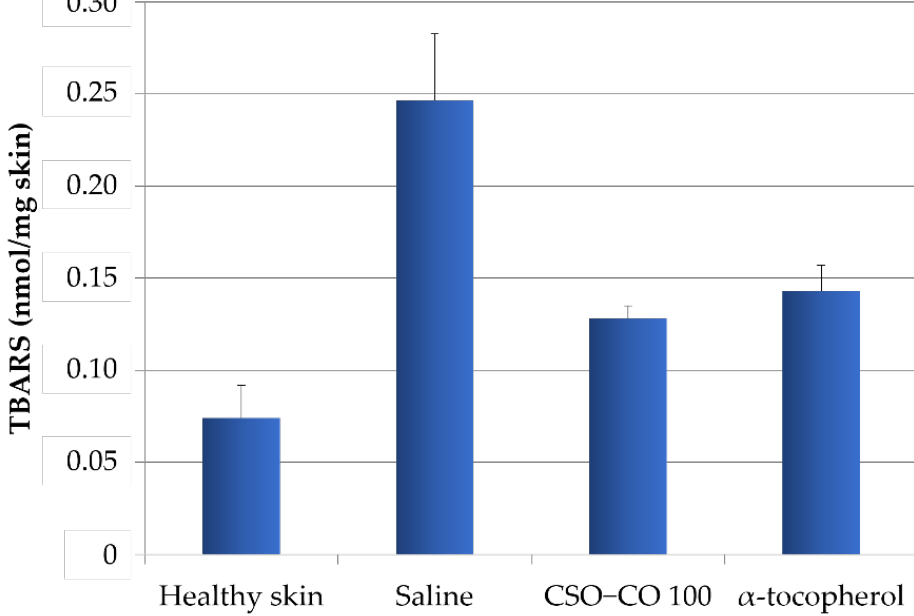
Figure 14. TBARS levels in healthy skin and wounds after 1 week of treatment with α -tocopherol and CSO – CO 100 (mean ± sd; n = 3).